Question: What does this figure show? Answer in one sentence.
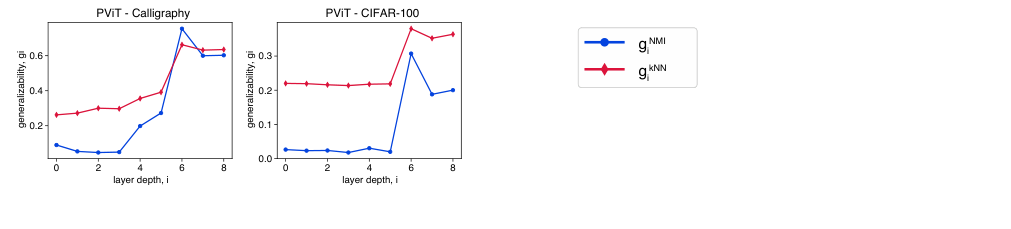
Answer: The generalizability trend across layers may vary considerably from model to model. Al- though deeper layers tend to better separate the examples from unseen classes, gi does not increase monotonically with depth, and for most models (ResNet, ViT, PViT, and PoolFormer) the best gen- eralization is found at intermediary layers. This hold true for both datasets used for fine-tuning (calligraphy or CIFAR), showing that this phenomenon does not seem dataset-specific. Moreover, similar trends were found regardless of the metric used (NMI or k-nearest neighbors) as demon- strated by qualitatively similar curve shapes, despite being based on completely different methods. In almost all cases, the two metrics identified the same layer as the one that best generalized to the unseen classes. Interestingly, the gi curves are also qualitatively similar across datasets, indicating that the patterns observed are due to the network’s architecture, and not the dataset.